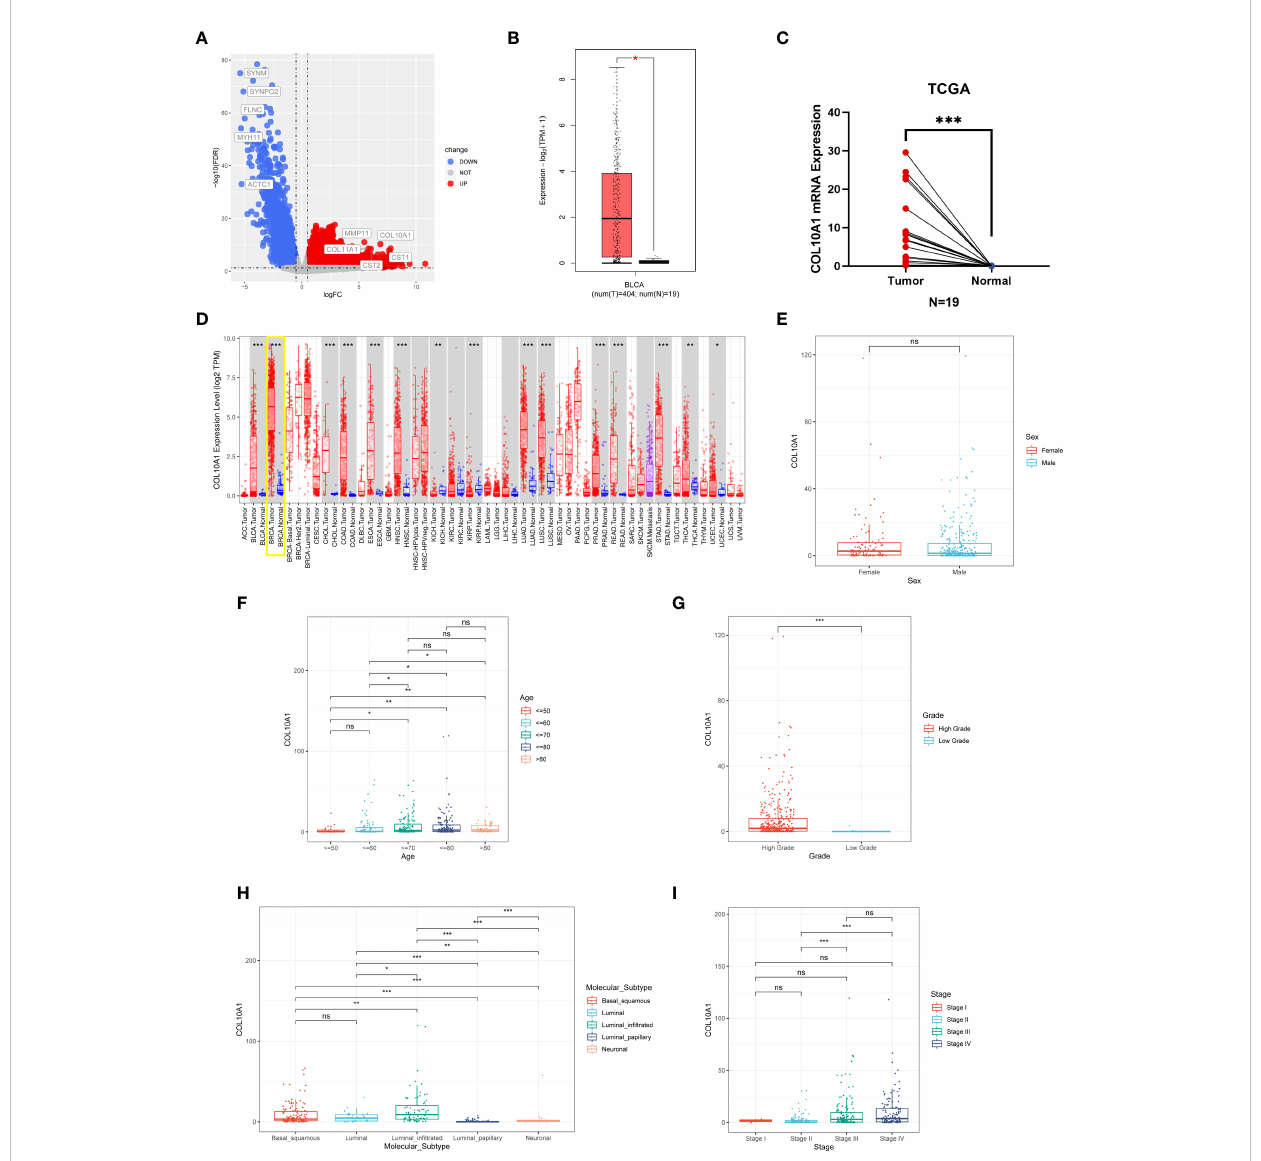
FIGURE 1 The expression of COL10A1 in BLCA and pan-carcinoma. (A) Differential genes in BLCA tissues compared with adjacent normal tissues based on the TCGA database. (B) The mRNA expression of COL10A1 in BLCA and matched non-carcinoma tissues based on the GEPIA database. (C) Paired expression analysis of COL10A1 in normal and BLCA tissues based on TCGA database. (D) COL10A1 expression data in various cancer types based on the TIMER database. To study the correlation of COL10A1 expression with clinical-pathological parameters, including sex (E) , age (F) , grade (G) , molecular subtypes (H) and stage (I) in BLCA patients. * P < 0.05; ** P < 0.01; *** P < 0.001, ns, not signi fi